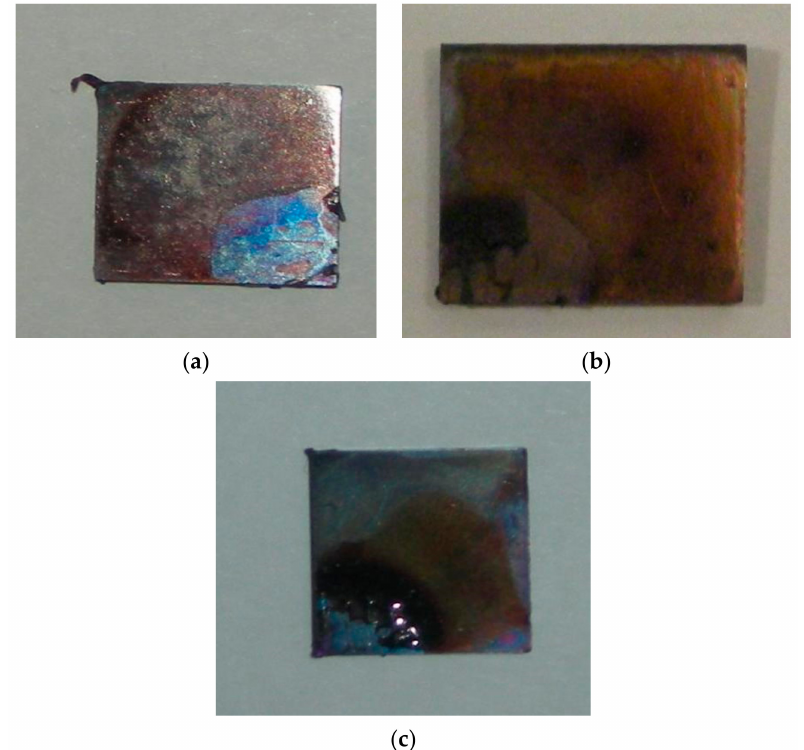
Figure 14. Chitosan coatings after colorization with Alizarin Red: ( a ) DD 87% sigma, ( b ) DD 87%, and ( c ) DD 94%. Magnification: 6 or 8 × ( b